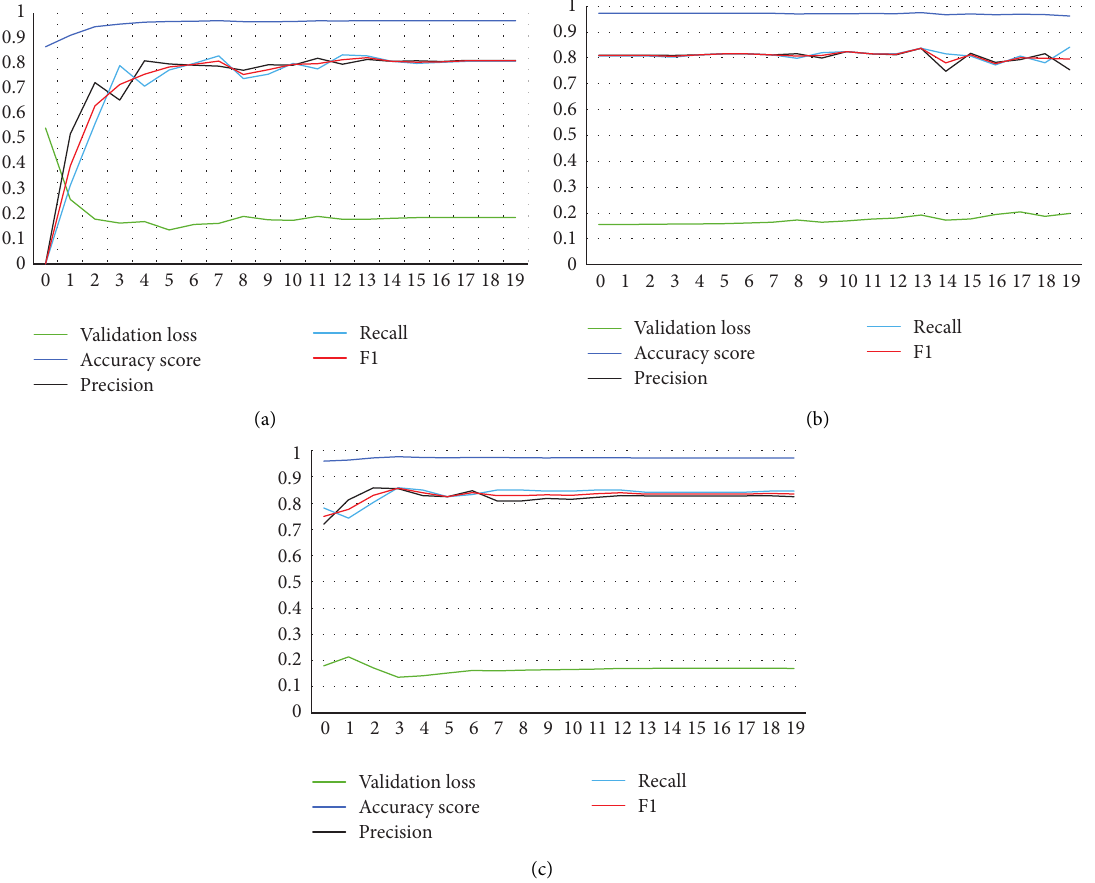
Figure 2: Test results for bioNER. (a) BERT multilingual cased. (b) AraBERT. (c) ABioNER.